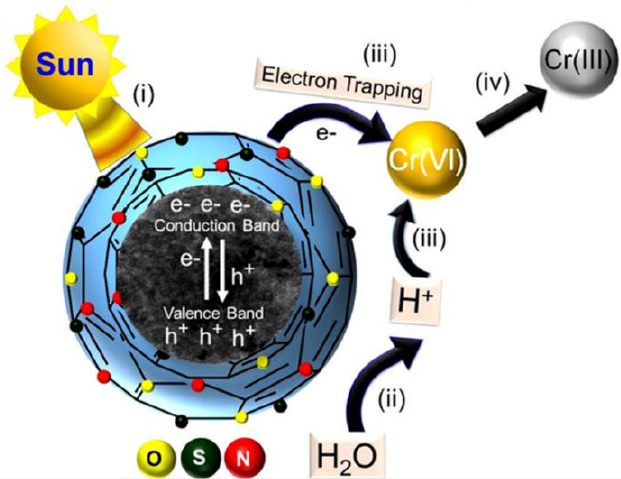
Figure 8. Proposed mechanism for the CD-mediated photoreduction of Cr(VI). Adapted with permission from [55]. Copyright 2020 American Chemical Society.